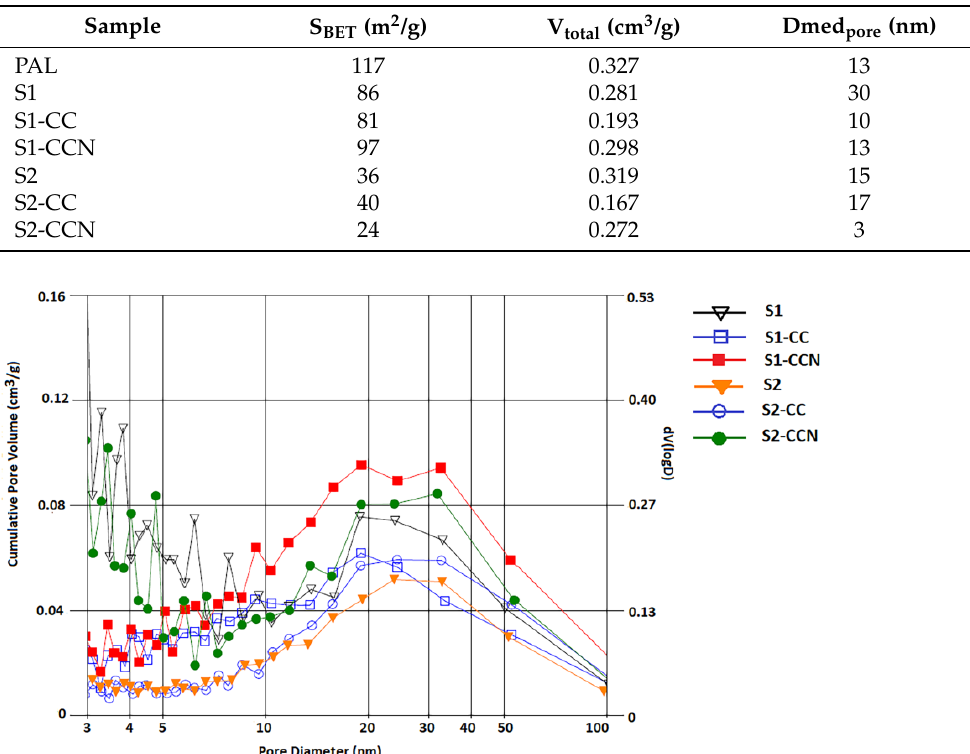
Table 2. Specific surface area, pore volume and average pore diameter of PAL and organic–inorganic hybrids.